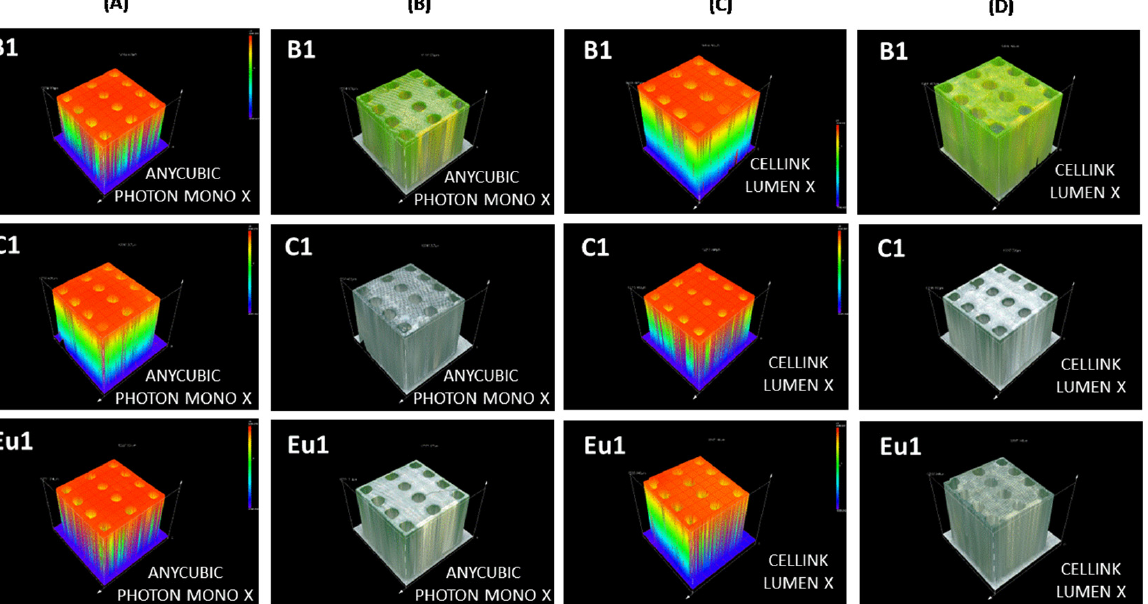
Figure 8. Three-dimensional spectra for cubes containing fluorophores B1, C1, Eu1 observed on the OLYMPUS DSX1000 optical microscope: ( A ) height of cubes made using the Anycubic Photon Mono X printer; ( B ) 3D view of cubes in sunlight made using the Anycubic Photon Mono X printer; ( C ) height of cubes made using the LumenX printer; ( D ) 3D view of cubes in sunlight made on the Anycubic LumenX